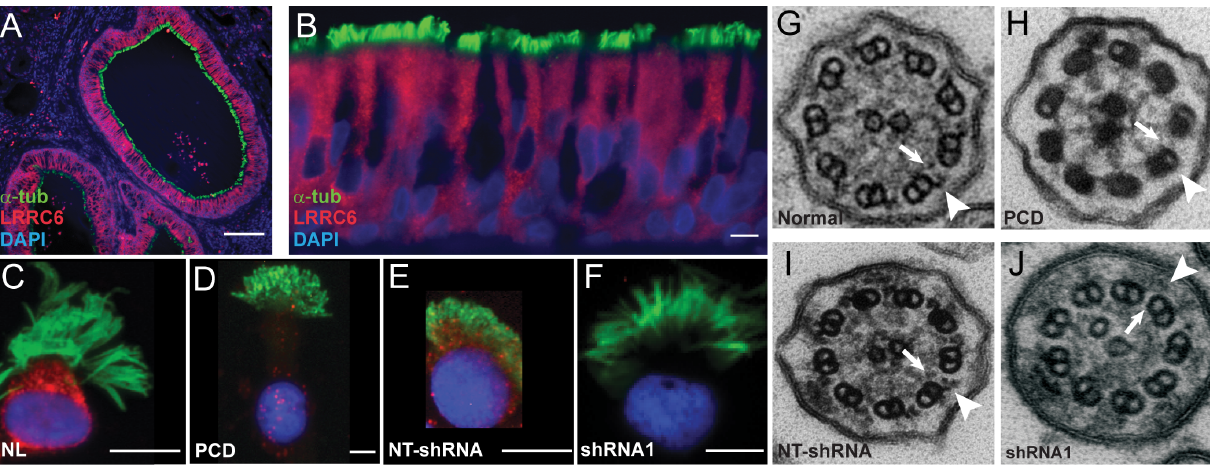
Figure 2. LRRC6 expression in ciliated airway epithelial cells. Photomicrographs of normal human lung section ( A ) (scale bar=100 m m) and bronchial epithelium ( B ) following immunofluorescent staining for LRRC6, which reveals the cytoplasmic localization of the protein (LRRC6, red) only in ciliated cells (acetylated a -tubulin, a cilia marker, green; DAPI: blue) (scale bar=10 m m). Immunofluorescent staining of nasal epithelial cells cultured at an air-liquid interface from a healthy subject demonstrating cytoplasmic localization of LRRC6 ( C ) as compared to decreased expression in a cell from a PCD subject ( D ). LRRC6 was similarly present in a non-targeted shRNA (NT) treated airway epithelial cells ( E ) but absent in LRRC6-specific shRNA transfected cells ( F ) (scale bar=10 m m). Ultrastructural appearance of cilia from a normal control ( G ), PCD subject ( H ) , and airway epithelial cells following transfection with non-targeted ( I ) and LRRC6- targeted ( J ) shRNA sequences. Arrow and arrow-head indicate inner and outer dynein arms,